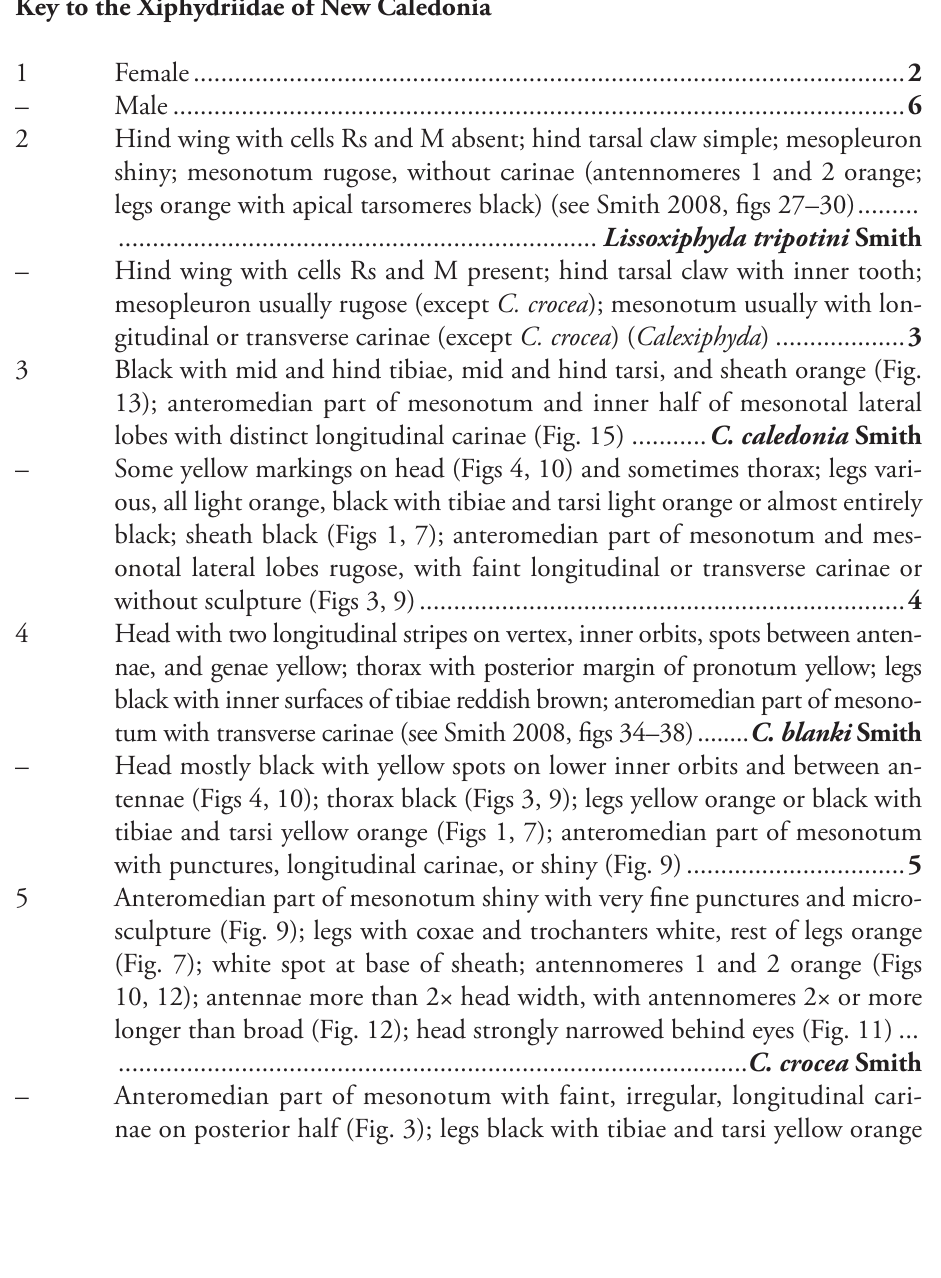
with punctures, longitudinal carinae, or shiny (Fig. 9) ................................ 5 Anteromedian part of mesonotum shiny with very fine punctures and micro- sculpture (Fig. 9); legs with coxae and trochanters white, rest of legs orange (Fig. 7); white spot at base of sheath; antennomeres 1 and 2 orange (Figs 10, 12); antennae more than 2× head width, with antennomeres 2× or more longer than broad (Fig. 12); head strongly narrowed behind eyes (Fig. 11)